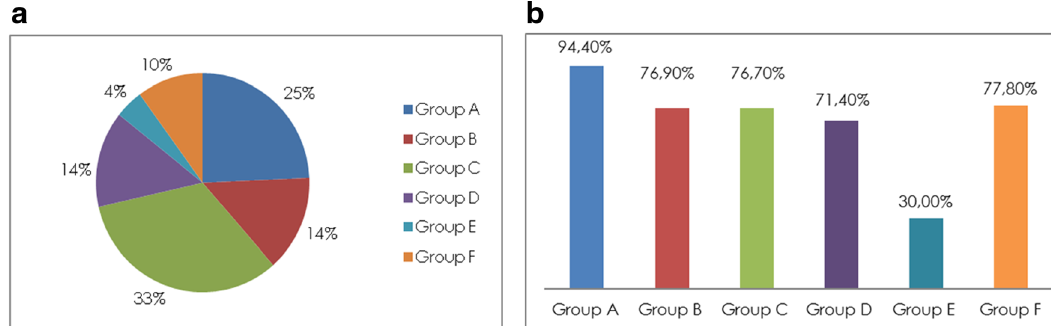
Fig. 4 a Allocation of stakeholders (%) in the six groups, b Response rates (%) per group (Own